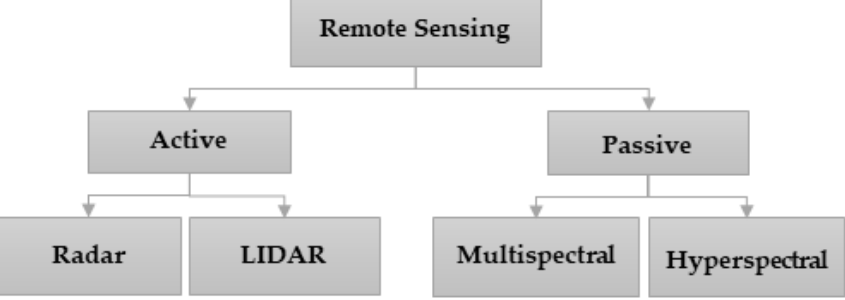
Figure 4. Classification of remote sensing methods.